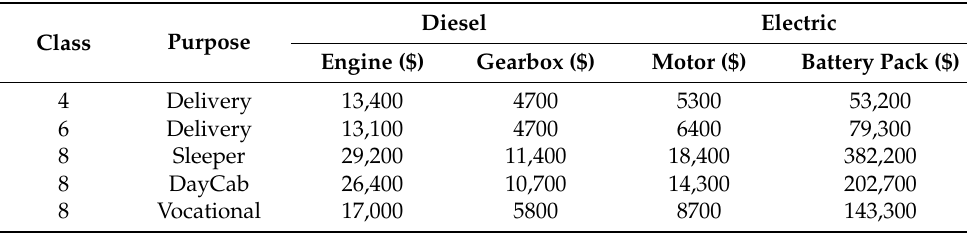
Table 3. Main component manufacturing cost comparison.